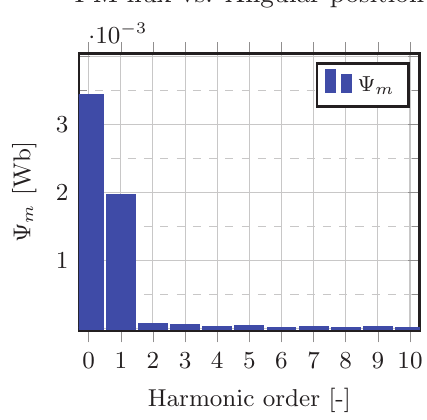
Figure 6. Harmonic spectrum of the PM flux linkage of the HM3D machine.